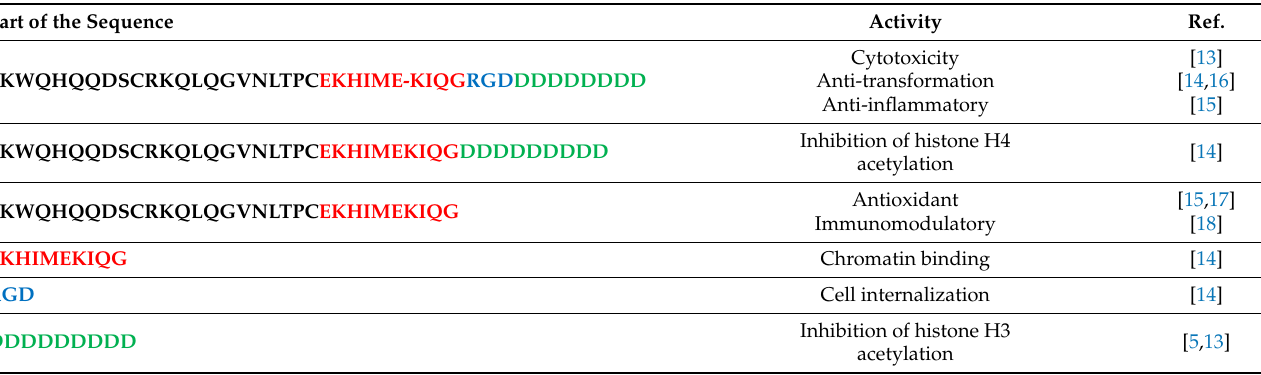
Table 1. Structure–activity relationship of lunasin. Anticancer-related activities reported are corre- lated with all parts of its